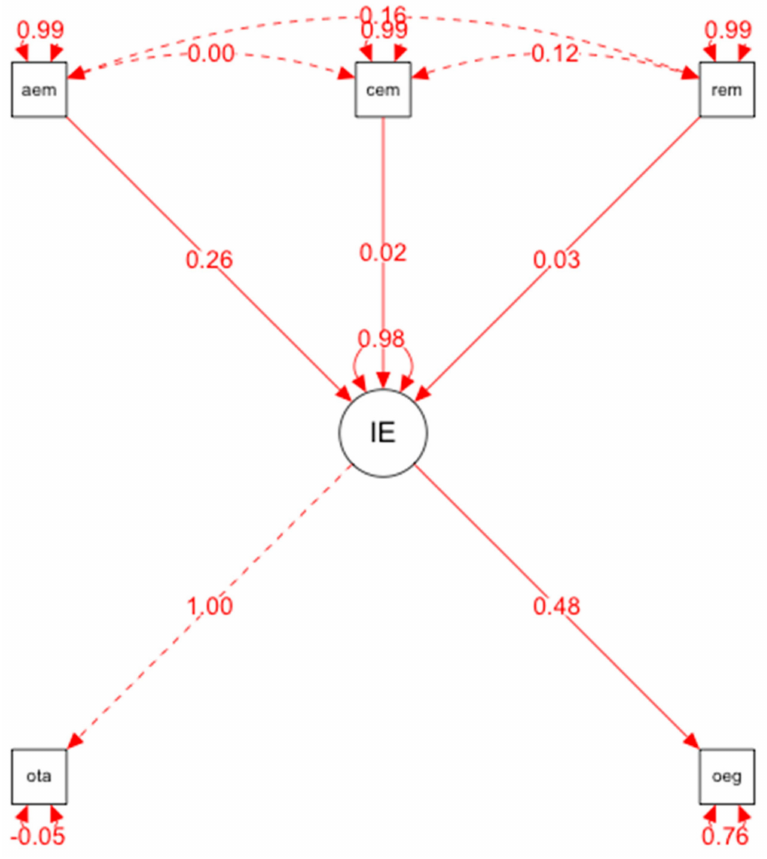
Figure 1. Representation of the results of the structural equation model: MIMIC.